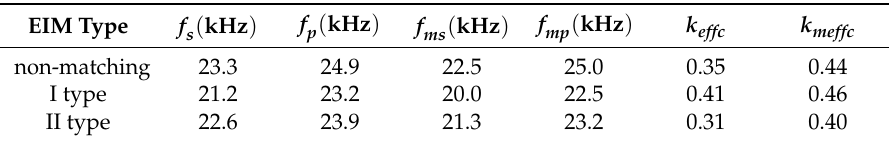
Figure 8. The impedance analysis results, ( a – c ) the simulated results and ( d – f ) the measured results. According to Figure 8a,d, the resonance and anti-resonance frequencies and effective electromechanical coupling coefficient are listed in Table 3. In Table 3, k are the simulated and measured resonance, anti-resonance frequencies, and the effective meffc electromechanical coupling coefficient, respectively. Table 3. Measured and simulated resonance, anti-resonance frequencies and the effective electromechanical coupling coefficient. EIM Type EIM